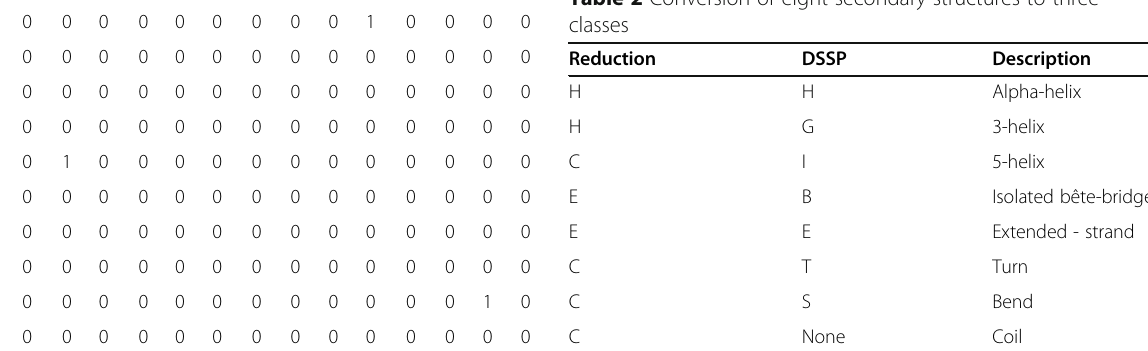
Table 2 Conversion of eight secondary structures to